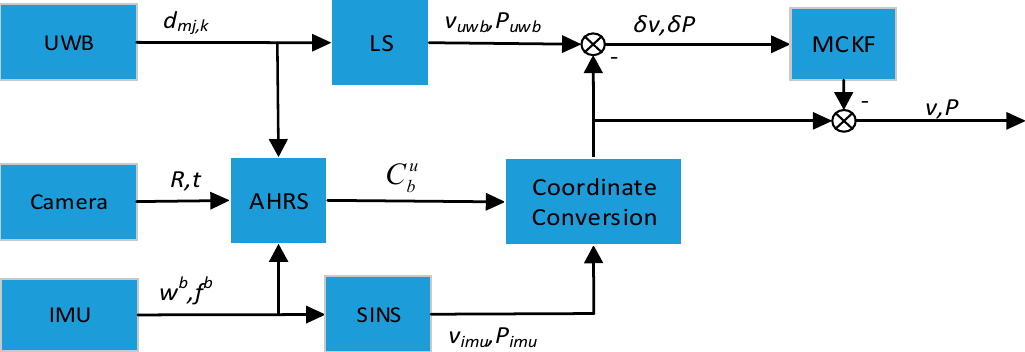
Figure 3. The Architecture of the positioning system.